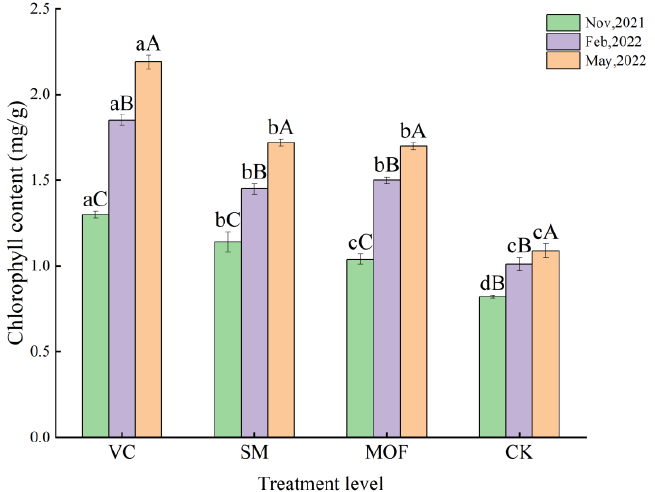
Figure 5. Effects of different bio-organic fertilizer treatments on chlorophyll content of “Qi-Nan” agarwood seedlings. No fertilizer (CK); vermicompost (VC); sheep manure (SM); microbial organic fertilizer (MOF). Capital letters represent significant differences at the 0.05 level ( p ≤ 0.05) for the same treatment and different periods, and lowercase letters represent significant differences at the 0.05 level ( p ≤ 0.05) for the same period and different treatments.